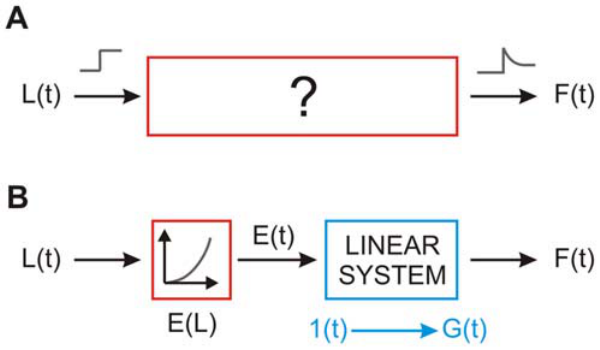
Figure 1. Schematic view of Fung’s theory. A : In most biological passive materials, a stepwise change in elongation (gray trace on the left) causes the force to suddenly increase and then decay over time (gray trace on the right). B : Fung proposed that this response scales with the size of the step, and that there is a nonlinear relationship E(L) between the peak force and the step size (which he called elastic response). He also posited that the decaying response is generated by a linear system, which can be described in terms of its step response. G(t) is then the response of the linear subsystem to a unitary step, 1(t), of the elastic response. This is a cascade of a static nonlinearity and a linear system, often referred to as a Hammerstein system. The model is not limited to reproducing the response to a strain step, but can be used to predict the response to an arbitrary strain history. Blue blocks indicate linear processes, whereas red blocks indicate the presence of a